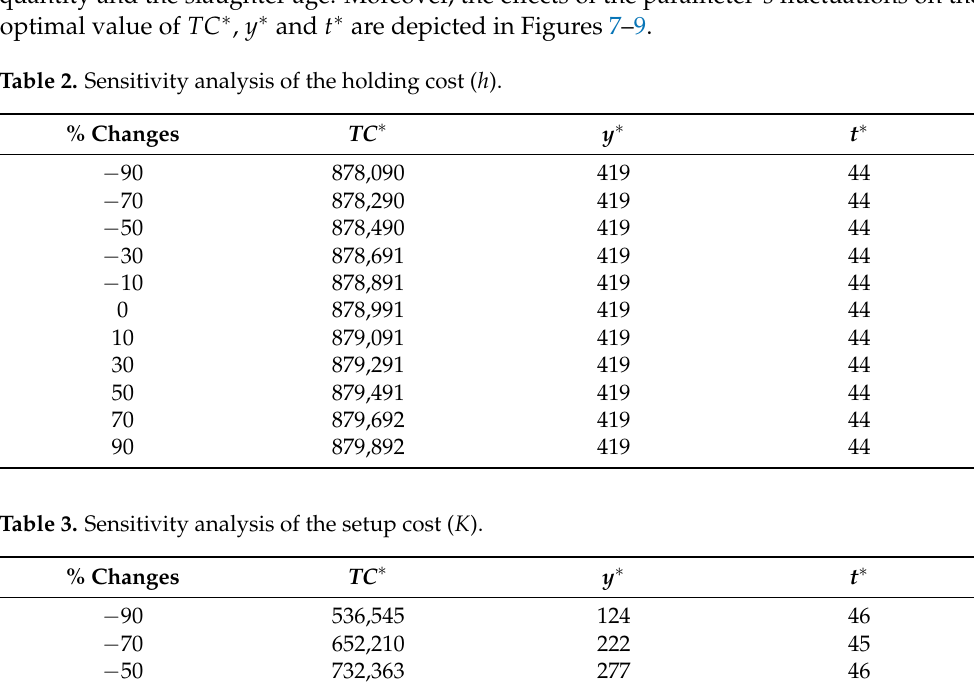
Figure 6. The value of the objective function regarding slaughter age.